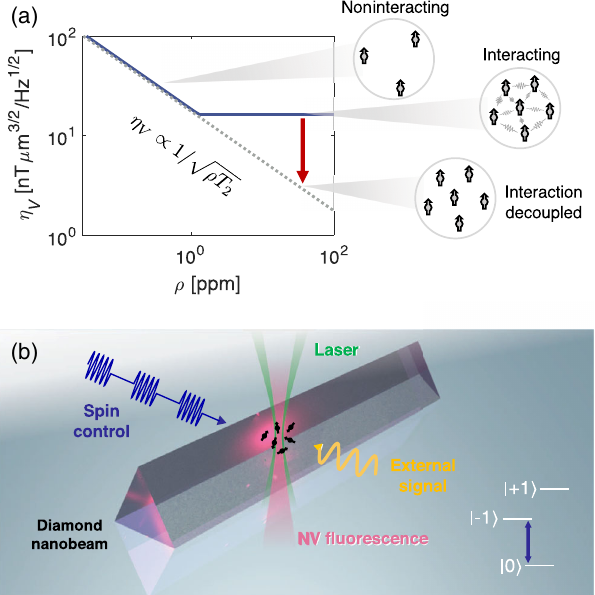
FIG. 1. Interaction limit to spin ensemble quantum sensing. (a) Volume-normalized magnetic field sensitivity as a function of total spin density. The dashed line denotes the standard quantum limit scaling and the solid curve shows the behavior when interactions between spins are taken into account for the typical readout efficiency factor C ≈ 0 . 0028 [27]. The sensitivity pla- teaus beyond a critical density due to a coherence time reduction. Robust interaction decoupling (red arrow) allows us to break the interaction limit. (b) Illustration of the black diamond nanobeam used as a spin ensemble quantum sensor. Microwave and optical excitation are delivered to the NV spins to control and read out their spin states, and an ac magnetic field is used as a target sensing signal. The inset shows the three magnetic sublevels, j 0 i and j (cid:3) 1 i , in the ground state of NV centers, where two levels j 0 ; − 1 i are addressed using resonant microwave driving. All measurements are performed at room temperature under ambient